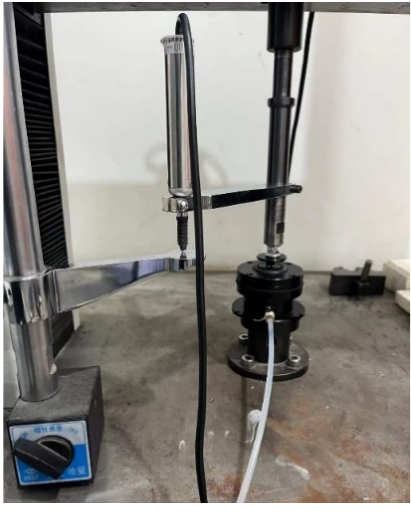
Figure 8. HSU on the testing machine.